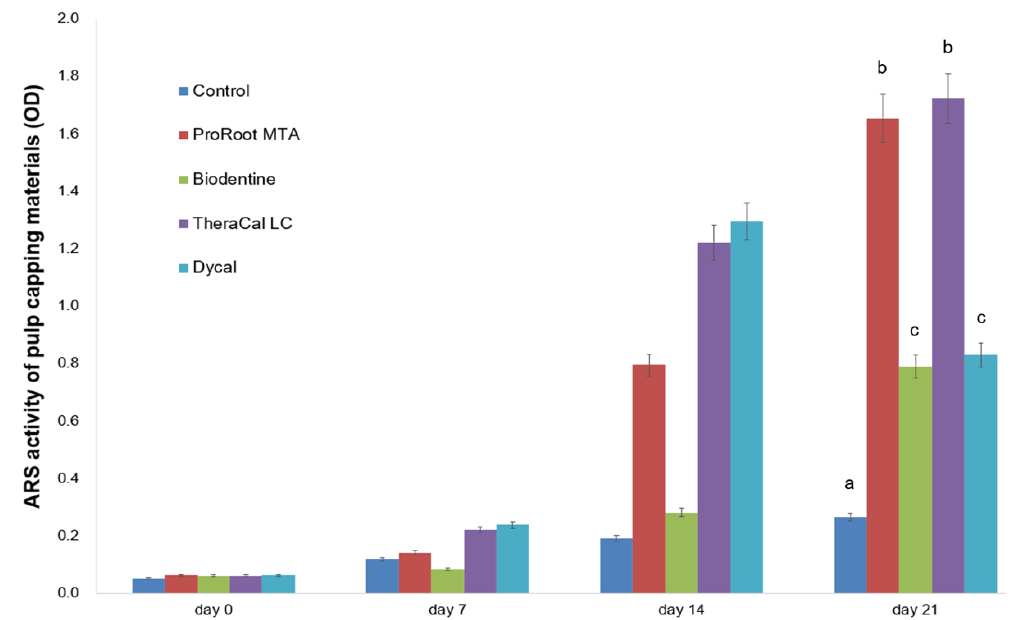
Figure 5. Determination of calcium nodule formation by Alizarin red S (ARS) staining assay. Different letters represent statistically significant differences among experimental groups.